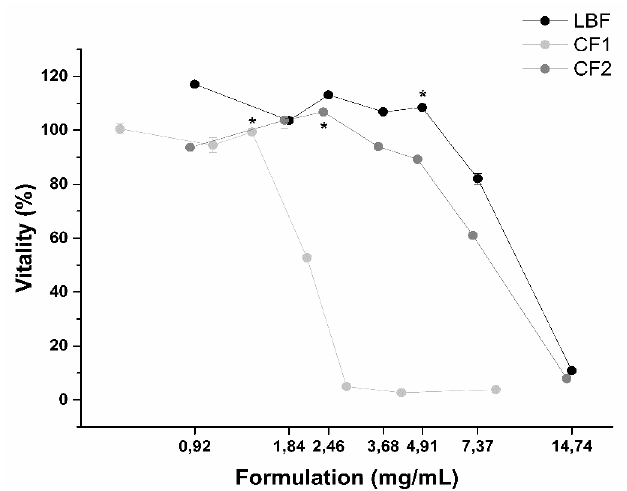
Figure 9. Impact of formulations on intestinal mucosa viability evaluated by determining dose-response curves on formulation concentrations. * Highest non-toxic concentration. ( n = 3). Table 5. Half maximal effective concentrations (EC 50 ) from dose-response curves.